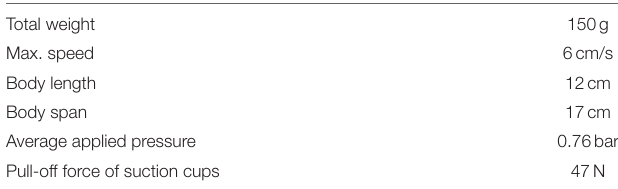
TABLE 1 | Specifications of the soft